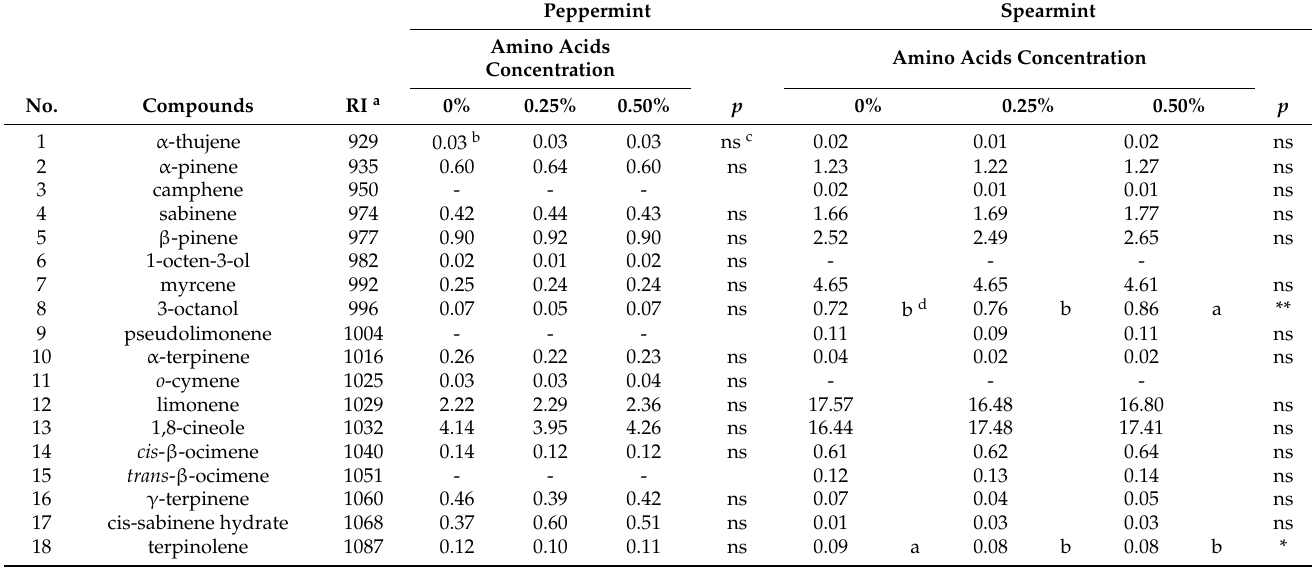
Table 2. Essential oil composition of peppermint and spearmint plants grown in floating system in which 0, 0.25 or 0.50% of a commercial PH solution (Amino16 ® ) was